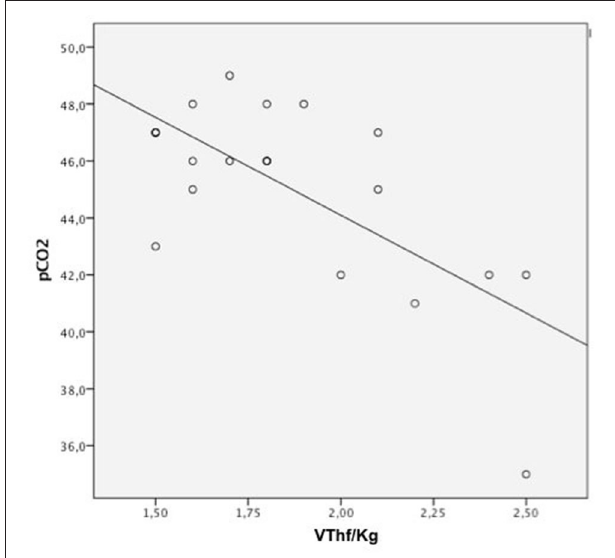
FIGURE 3 | Pearson correlation analysis between VThf/kg, pCO2 significant correlation between all VThf/kg and pCO2 levels (Pearson coefficient: r = − 0.69, p <